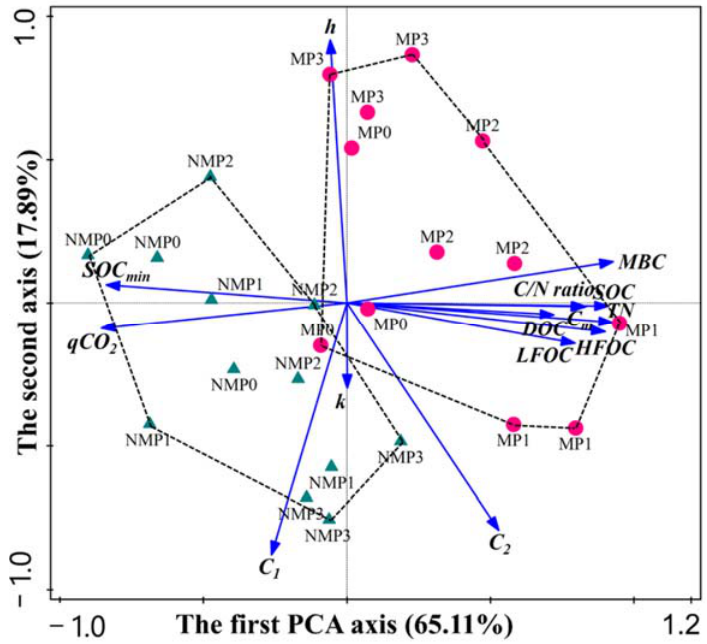
Figure 5. Principal component analysis (PCA) for SOC fractions, SOC mineralization, and SOC mineralization kinetic parameters for all treatments. SOC: soil organic carbon; TN: total nitrogen; C/N ratio: SOC to TN ratio; LFOC: light fraction organic carbon; HFOC: heavy fraction organic carbon; MBC: microbial biomass carbon; DOC: dissolved organic carbon; C m : cumulative SOC mineralization over 175 days; q CO 2 : metabolic quotient; SOC min : SOC mineralization intensity; k: active SOC mineralization rate constant; h: slow SOC mineralization rate constant; C 1 : active SOC fraction; C 2 : slow SOC fraction.